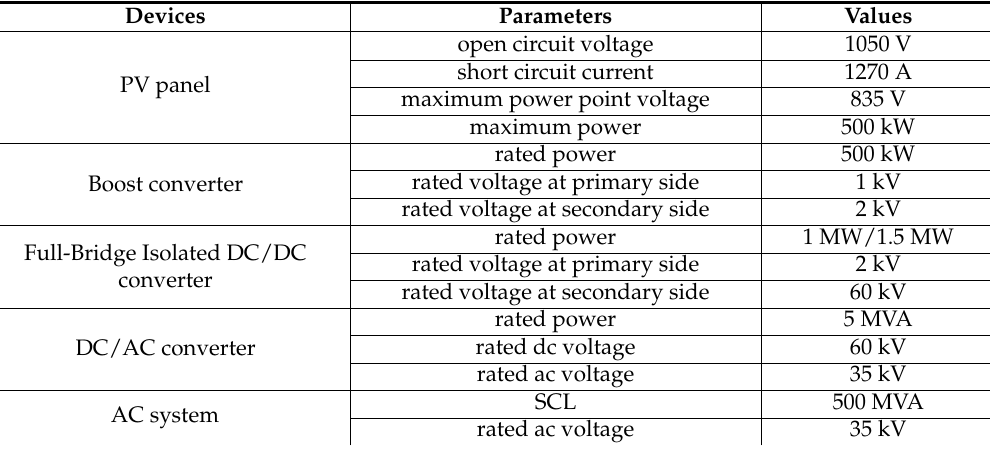
Table 1. Parameters of the Modeled System.